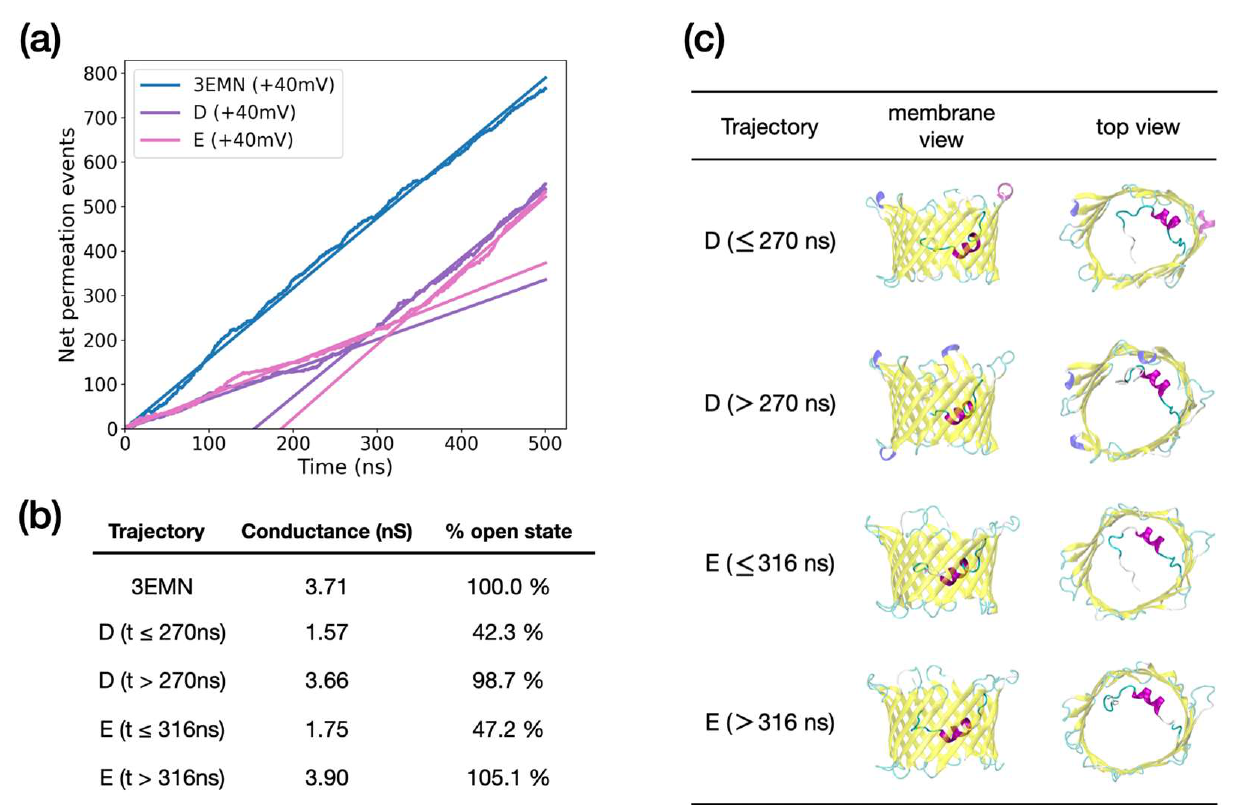
Figure 5. ( a ) Net ion permeation events recorded from unbiased MD at applied voltage. Trajectories were initiated from 3EMN and 2 conformers extracted from aMD at +40 mV, referred to as D and E. For each curve, simple linear regression was performed (straight lines). As trajectories D and E exhibited two conducting trends, two linear regressions, one before and one after the bifurcation point, were conducted. Bifurcation points were estimated at 270 ns and 316 ns for D and E, respectively. ( b ) Conductance deduced from the slope of the ion permeation curves. The slopes correspond to the electric current, which after renormalization and division by the applied voltage, provides an estimate of the conductance. ( c ) Average structures of MD trajectories in side view (membrane) and top